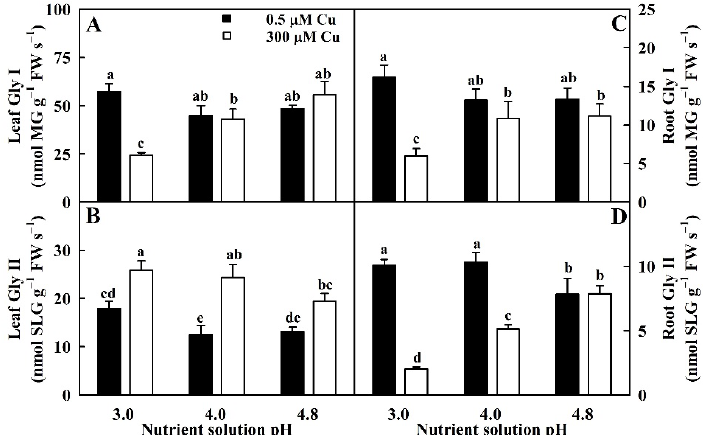
Figure 4. Impacts of Cu–pH interactions on the activities of Gly I ( A , C ) and Gly II ( B , D ) in leaves and roots. Bars represent means ± SE ( n = 4). Different letters above the bars indicate a significant difference at p < 0.05. SLG, S-D-lactoylglutathione. 2.3. Impacts of Cu–pH Interactions on the C oncentrations and Ratios of Antioxidant Metabolites Involved in ROS and MG Scavenging in Leaves and Roots Cu toxicity elevated total ascorbate (TA, sum of ASC and DHA), ASC, and DHA con- centrations in leaves more at pH 3.0 than at pH 4.0–4.8. Cu toxicity enhanced TA, ASC, and DHA levels in roots more at pH 4.0 than at pH 4.8, but it reduced TA and ASC levels and did not affect DHA levels in pH-3.0-treated roots. Compared to pH 4.8, low pH in- creased TA, ASC, and DHA concentrations in LCu300 relative to pH 4.8 while repressing their concentrations in RCu300 except for a similar DHA concentration. TA, ASC, and DHA concentrations in LCK and RCK remained unchanged at pH 3.0–4.8. ASC redox state (ASC/TA ratio) in leaves and roots did not differ between Cu–pH combinations except for a drop in pH 3.0 + 300 μM Cu (Figure 5). Total glutathione (TG, sum of GSH and oxidized glutathione (GSSG)) and GSH levels in leaves and GSSG levels and GSH redox state (GSH/TG ratio) in leaves and roots were similar between Cu–pH combinations except for a drop under pH 3.0 + 300 μM Cu. Cu toxicity reduced TG and GSSG levels in roots. Low pH lowered TG and GSSG levels in RCu300 relative to pH 4.8. TG and GSSG levels in RCK remained stable at pH 3.0–4.8 (Figure 5).